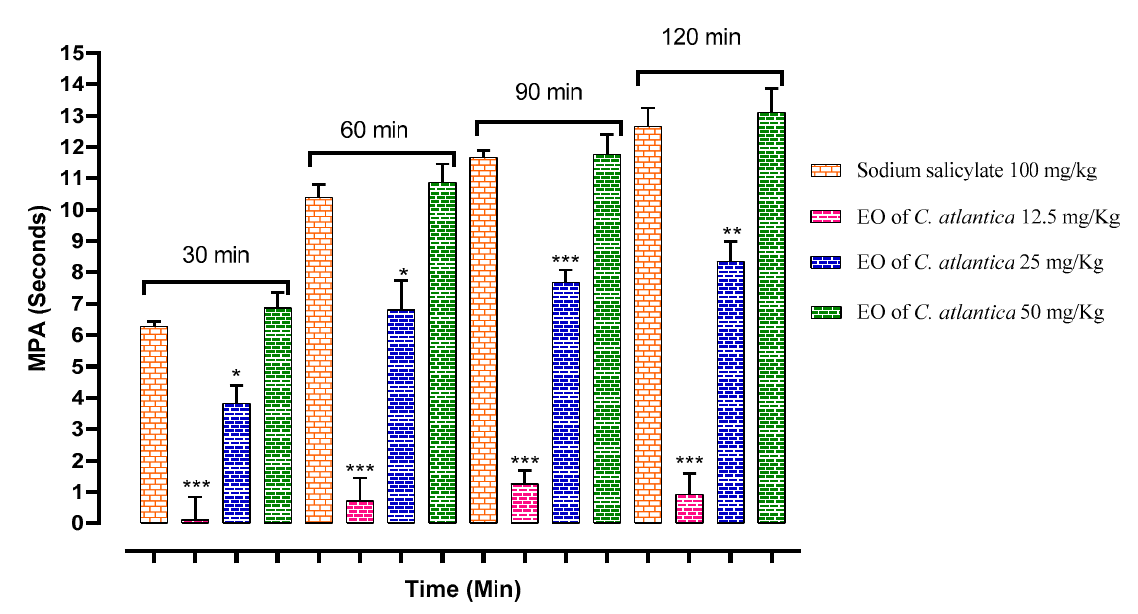
Figure 4. Effect of essential oil of C. Atlantica on the antinociceptive effect of the hot plate. Values are expressed as mean ± SD ( n = 5). * p < 0.05, ** p < 0.01, *** p < 0.001 compared with positive control. MPA: The maximum possible analgesia (%) representing the effect of C. Atlantica essential oil (CDEO) versus sodium salicylate (positive control) administered to Swiss Albino mice, assessed by the hot plate method.